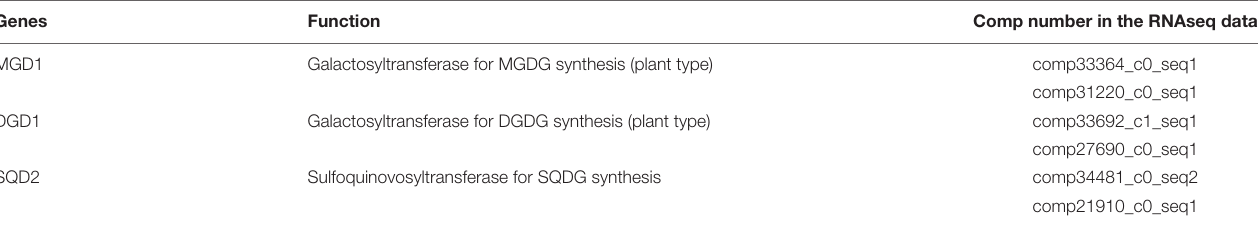
comp31220_c0_seq1